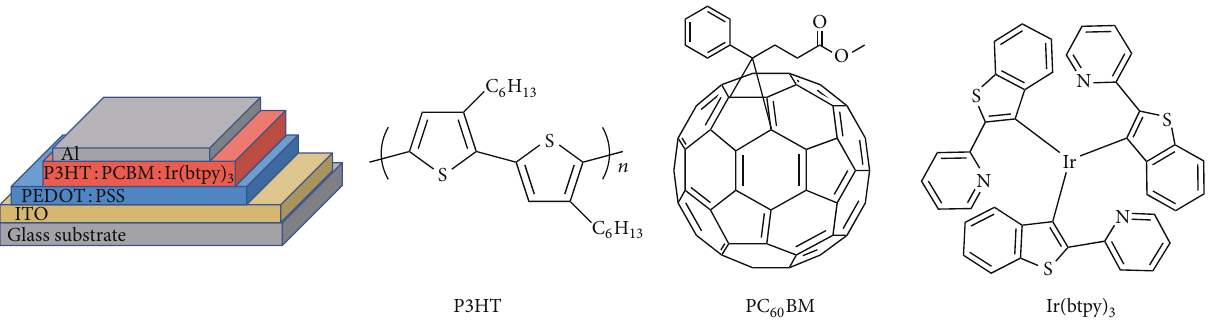
Figure 1: Schematic structure configuration of PSCs and chemical structures of used organic materials.